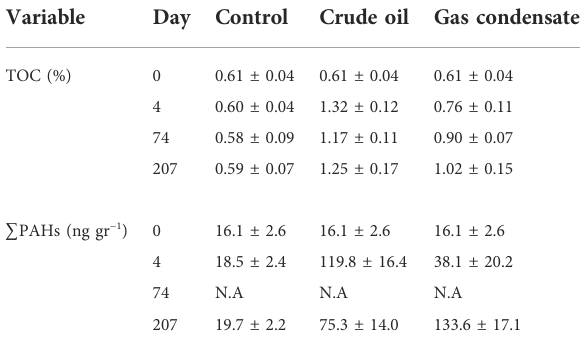
TABLE 1 Values of total organic carbon (TOC) and total polycyclic aromatic hydrocarbons ( (cid:1) PAHs) in the surface sediments following crude oil or gas condensate additions at discrete time points. N.A-not